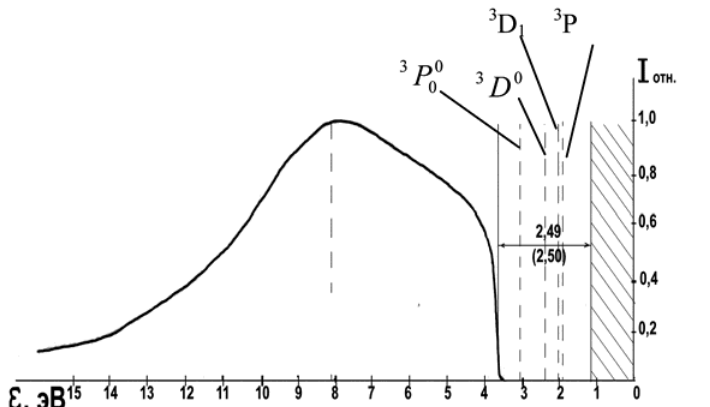
Figure 2 – General form of the first Brillouin zone for a silicon crystal Рис . 2 – Общий вид первой зоны Бриллюэна для кристалла